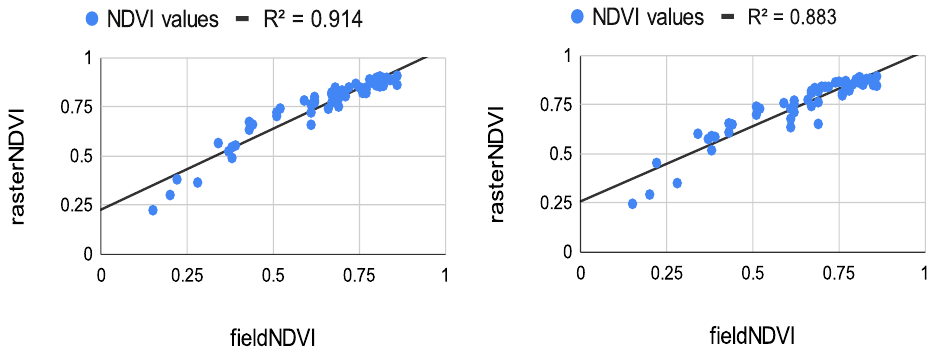
Figure 10. Correlation between the average NDVI values for the sample NDVI points and raster NDVI values from Sequoia ( left ) and multiSPEC 4c ( right ).